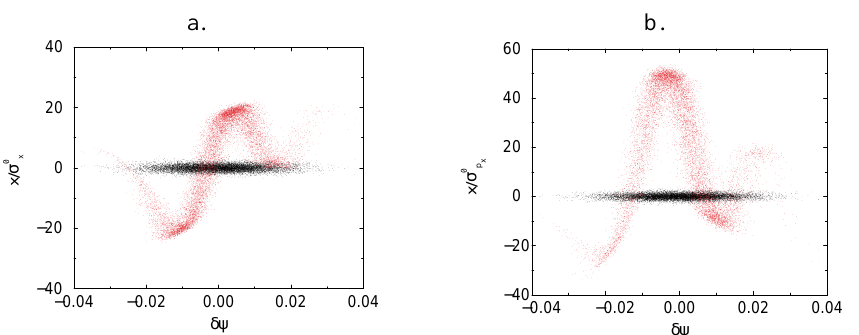
FIG. 4. (Color) Additional cross sections of the initial (black) and final (red) phase space: (a) transverse coordinate vs longitudinal phase, (b) transverse momentum vs longitudinal